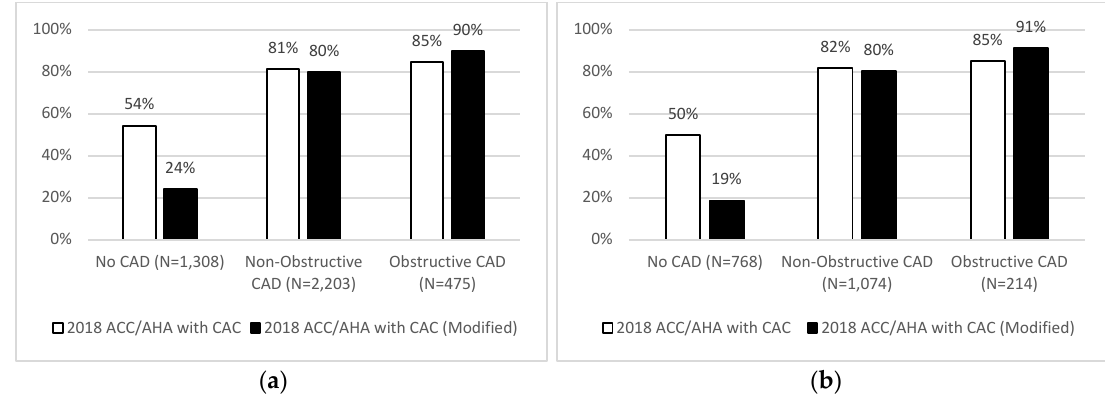
Figure 3. ACC/AHA statin eligibility versus modified statin eligibility stratified by presence and extent of CAD in: ( a ) all patients; and ( b ) statin naïve patients.